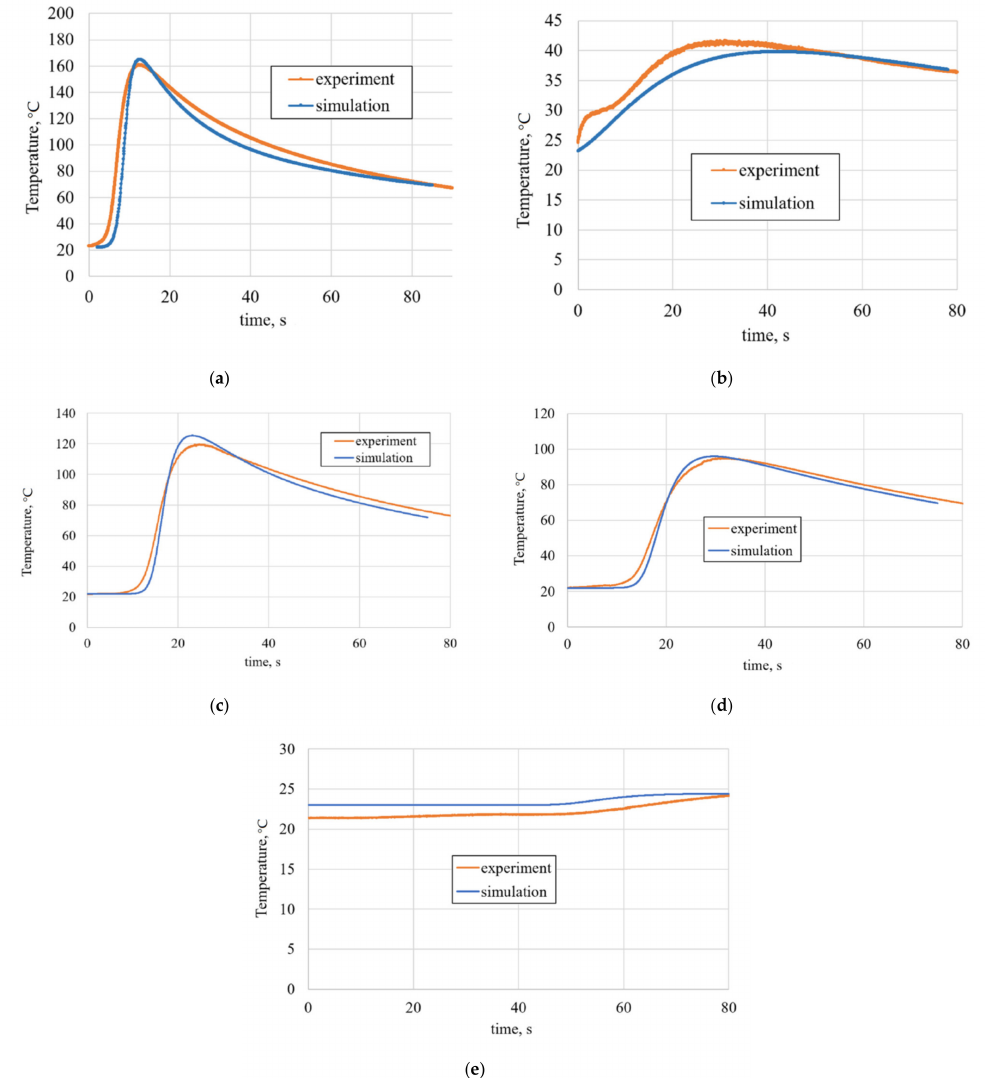
Figure 6. Thermal cycles for thermocouples: ( a ) № 7; ( b ) № 6; ( c ) № 1; ( d ) № 2; and ( e ) №